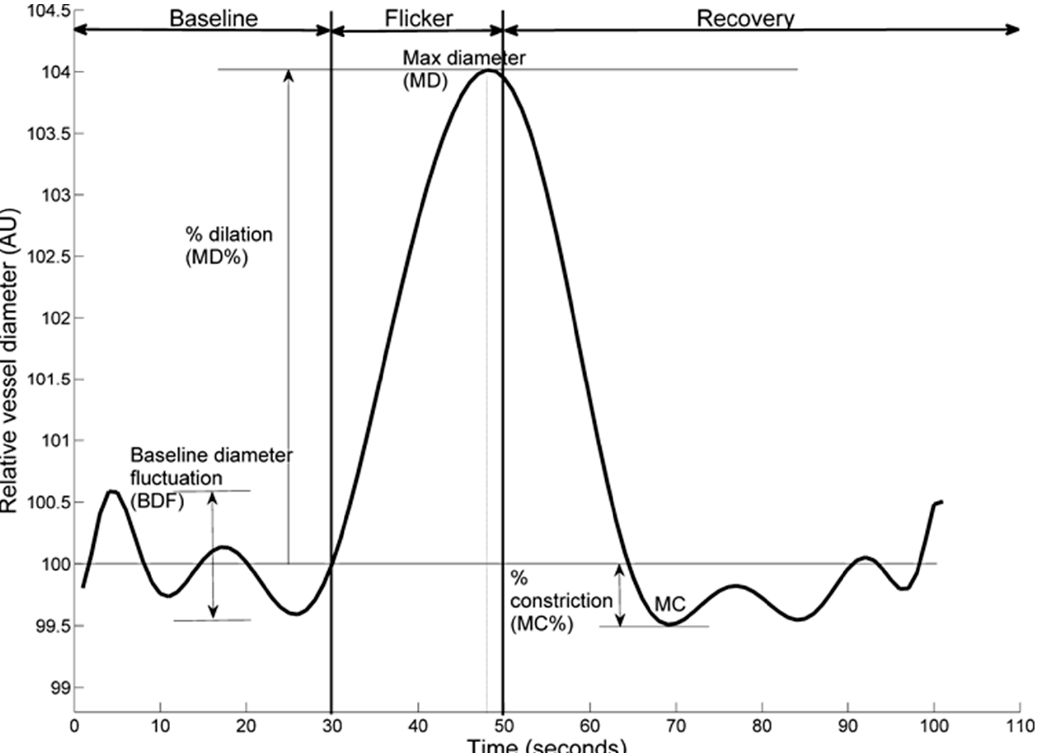
Figure 1. Example dynamic retinal arterial vessel response profile displaying parameters calculated and used in analysis. Percentage change in diameter from baseline to maximum (MD%) calculated as percentage increase in vessel diameter from baseline to maximum. Percentage constriction below baseline (MC%) calculated as percentage constriction below baseline following the point of maximum dilation.